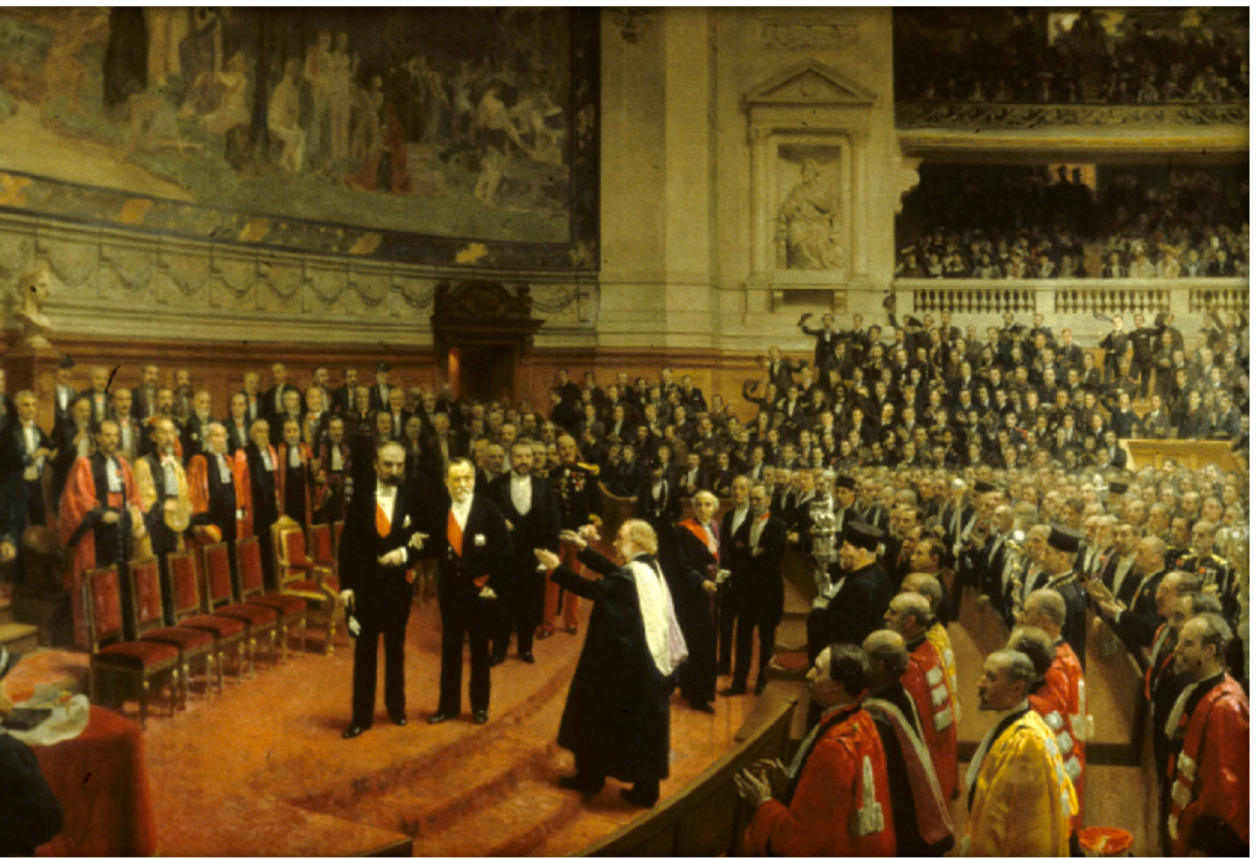
Figure 4. On 27 December 1892, for his 70th birthday, the international scientific community cele- brated Pasteur’s “jubilé”. The reception took place in the great amphitheater of “la Sorbonne”. On the picture, one sees the president of France, Sadi Carnot, helping Pasteur to walk and Lister climb- ing a few steps to congratulate Pasteur. Oil on canvas by Jean-André Rixens (1902). © Institut Pas- teur/Musée